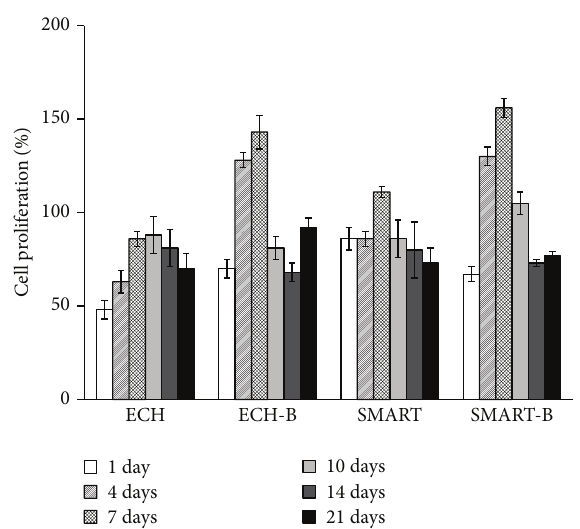
Figure 3: Cell proliferation on various Ti surfaces was detected using an MTS assay. Percentage of D1 cell proliferation on various Ti surfaces coated with or without BMP-2 for 1, 4, 7, 10, 14, and 21 d ( 𝑛 = 5 ) (ECH-B: ECH-BMP-2; SMART-B: SMART-BMP-2).